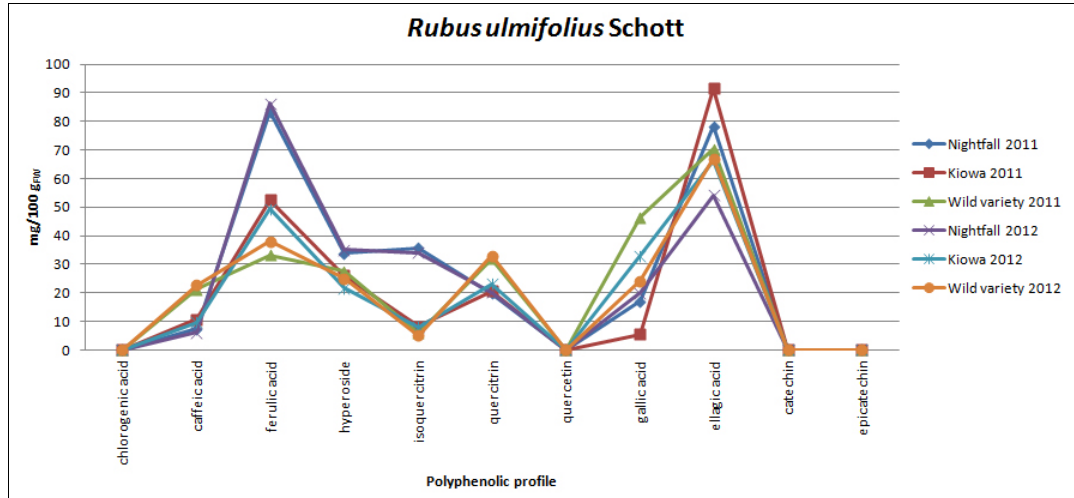
Fig. 6: Rubus ulmifolius : single polyphenolic profiles in University bud -preparations.